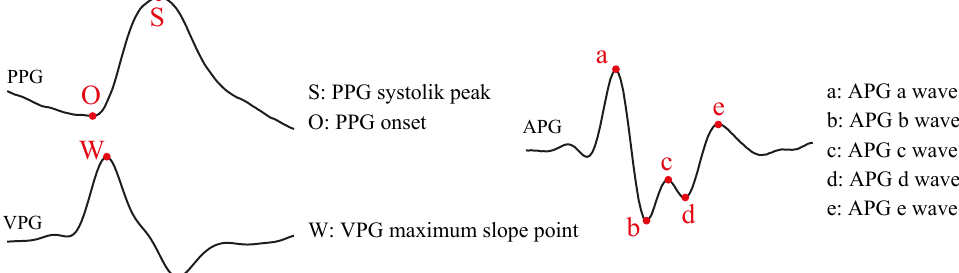
Figure 1. Graphical definition of fiducial points detected from photoplethysmogram (PPG), velocity plethysmogram (VPG) and acceleration plethysmogram (APG)